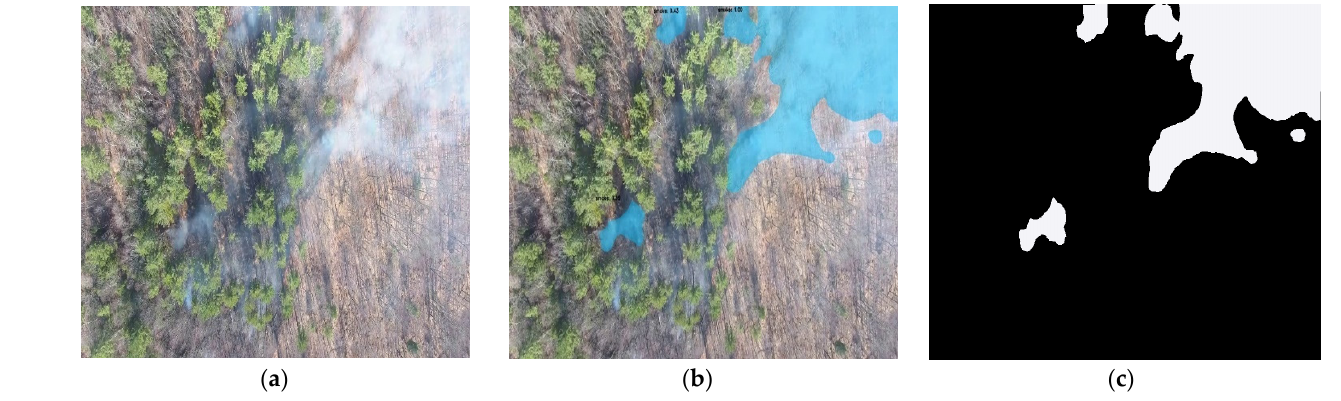
Figure 3. Description of our model results. We divided our results into three parts: ( a ) raw images, ( b ) instance segmentation, and ( c ) ground truth.